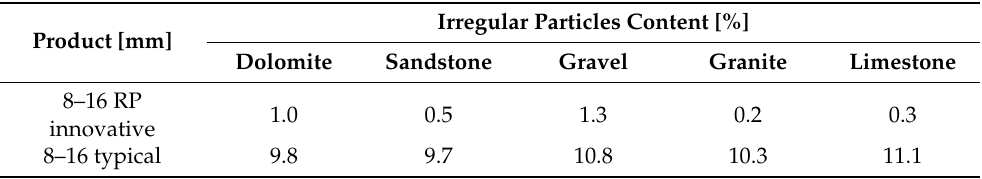
Table 8. Mass balance with separation into fractions with regular particles (RP) and irregular particles (IP). Mass Yield of RP and IP in Products Product [mm]